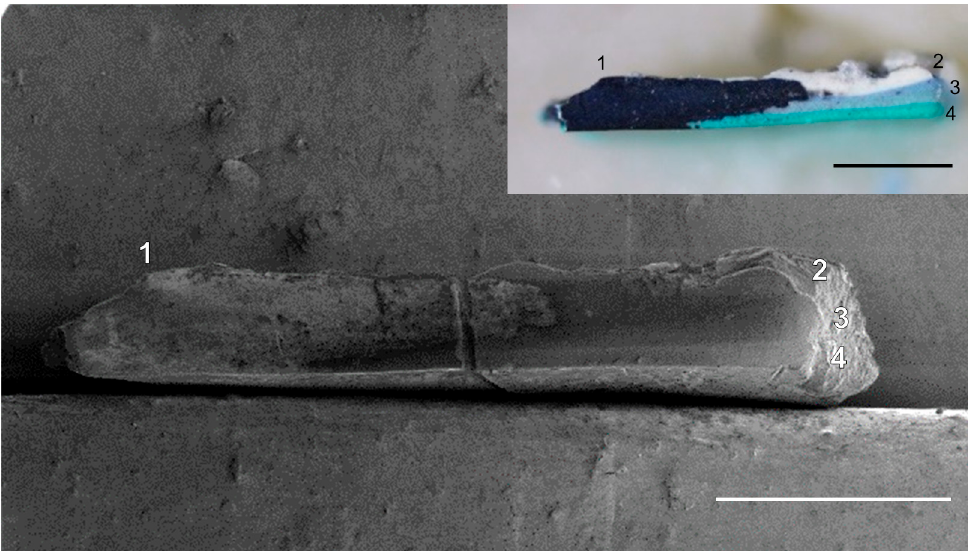
Figure 5. SEM image of cross-section of sample 2 obtained by the femtosecond laser cut at 20 mW (6.4 J/cm 2 ) with the XY translational speed of 10 mm/s. The inset shows the optical image of the cross-section. The as-obtained topography of superficial oxidized deposits on the cross-section ( 1 ) is observable while the cleaned paint layers ( 2 – 4 ) show smooth cut. The scale bars are 500 μ m.